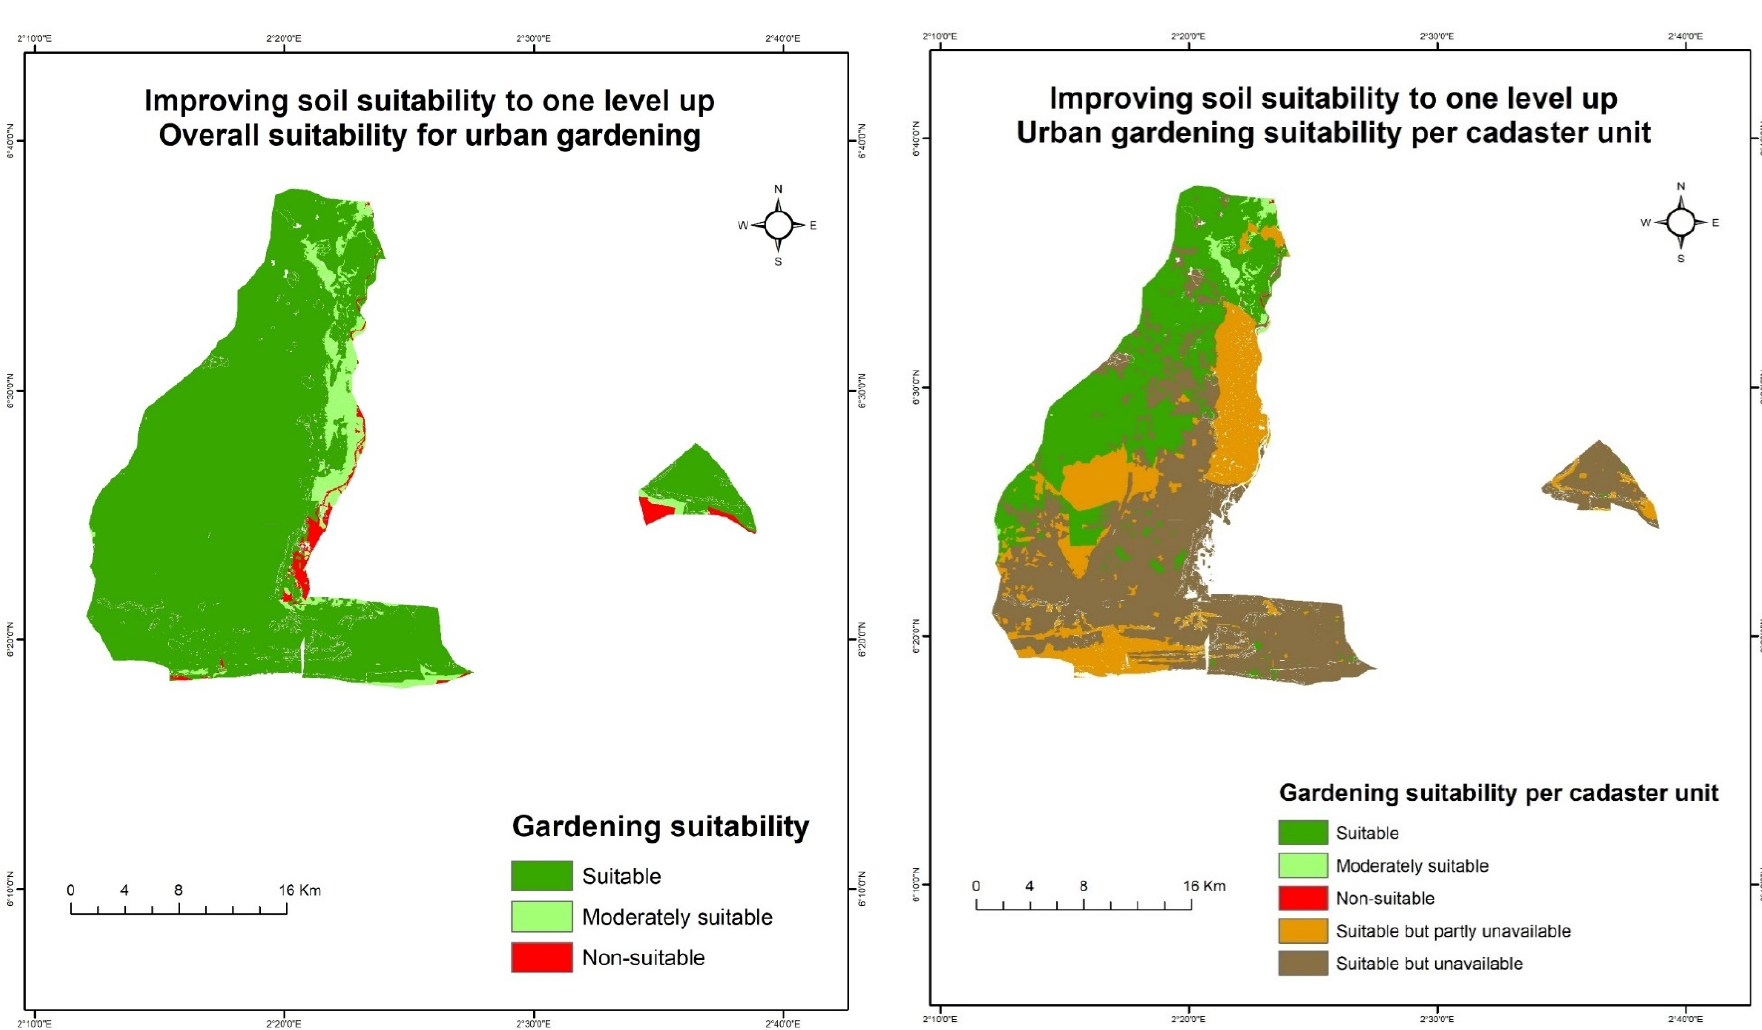
Figure 4. Classified maps of suitable areas for urban agriculture: soil improvement scenario. 0